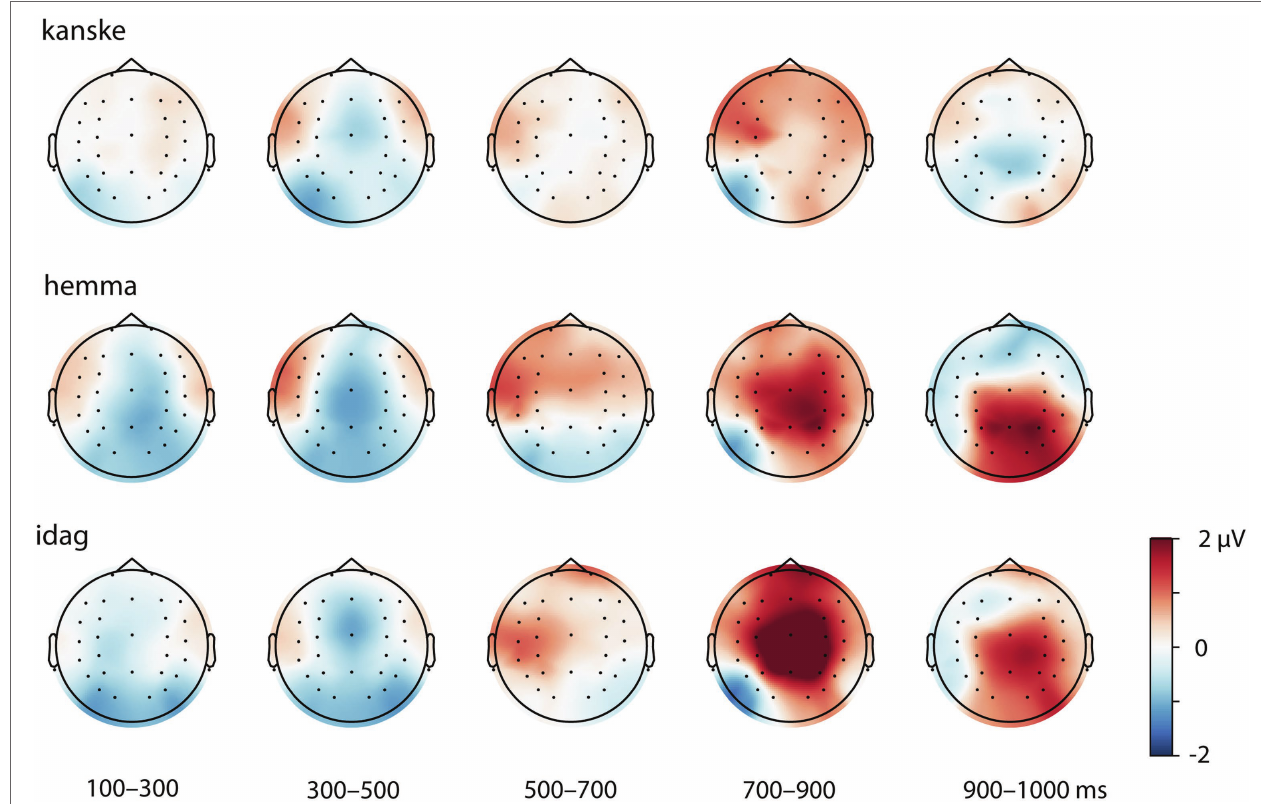
FIGURE 6 | Topographic plots derived from difference waveforms. That is, the ERPs to V2 word order subtracted from that to V3 word order following each of the adverbials presented in the analysed time windows (100–300, 300–500, 500–700, 700–900 and 900–1,000 ms). Negativities in blue and positivities in